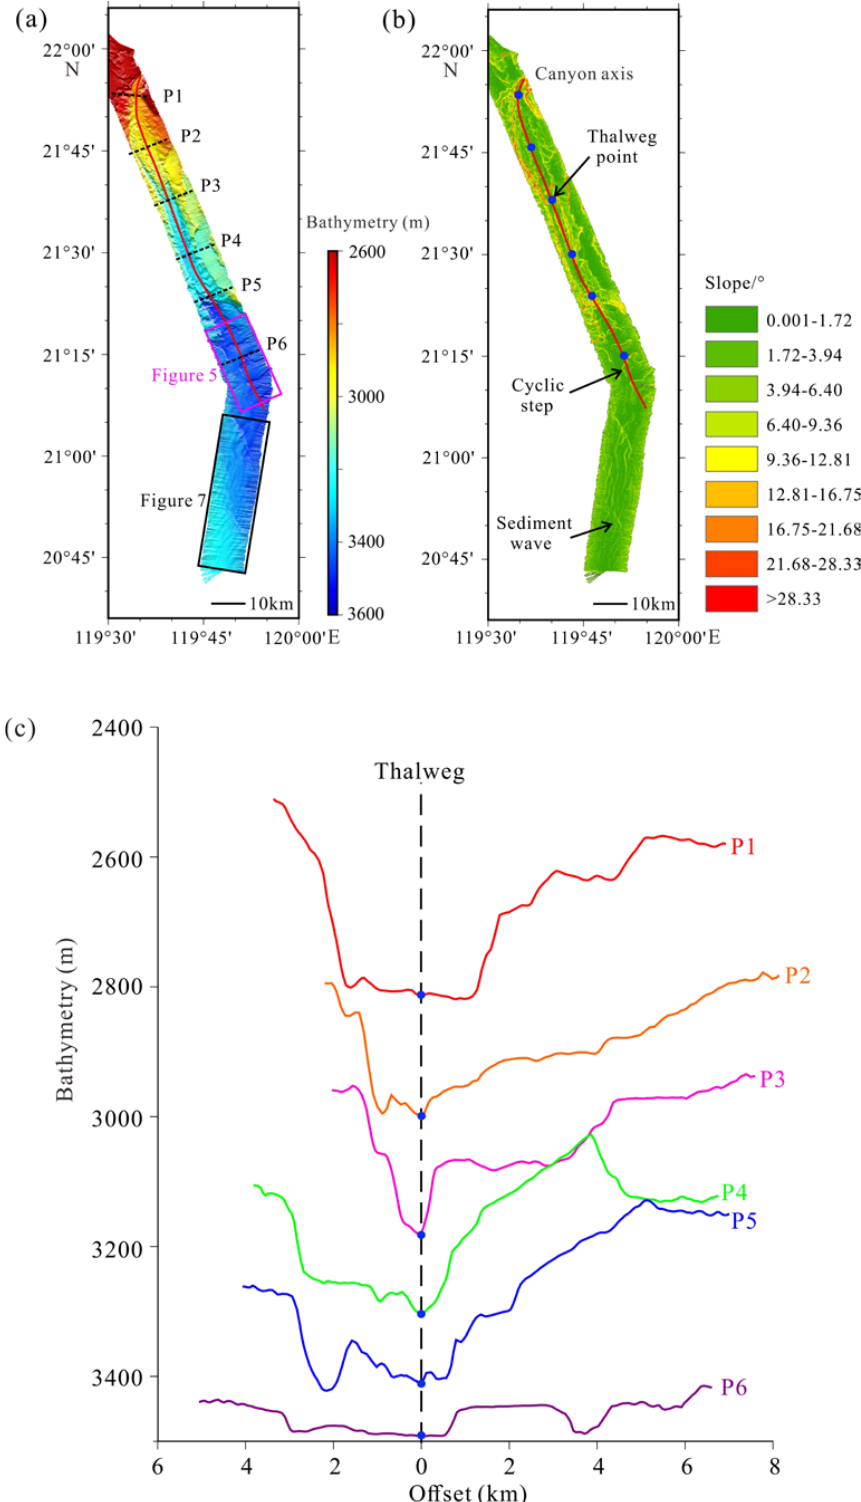
Figure 4. Geometry and slope map of the Penghu canyon. ( a ) Multibeam topographic map of the Penghu canyon. The solid red line is the axis of the canyon and the black dashed line is the location of the extracted topographic profiles; ( b ) slope map of the Penghu canyon. The blue dots are thalweg points. ( c ) Topographic profiles along the vertical axis of the Penghu canyon (P1–P6). The black dashed line is the thalweg